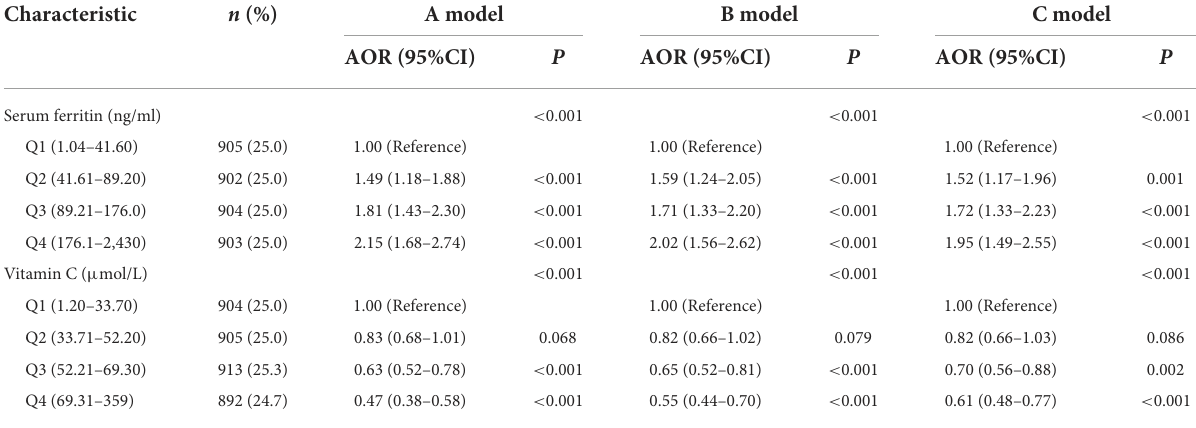
TABLE 3 Adjusted odds ratios of the association between the serum ferritin, Vitamin C, and non-alcoholic fatty liver disease in NHANES a . Characteristic n (%) A model B